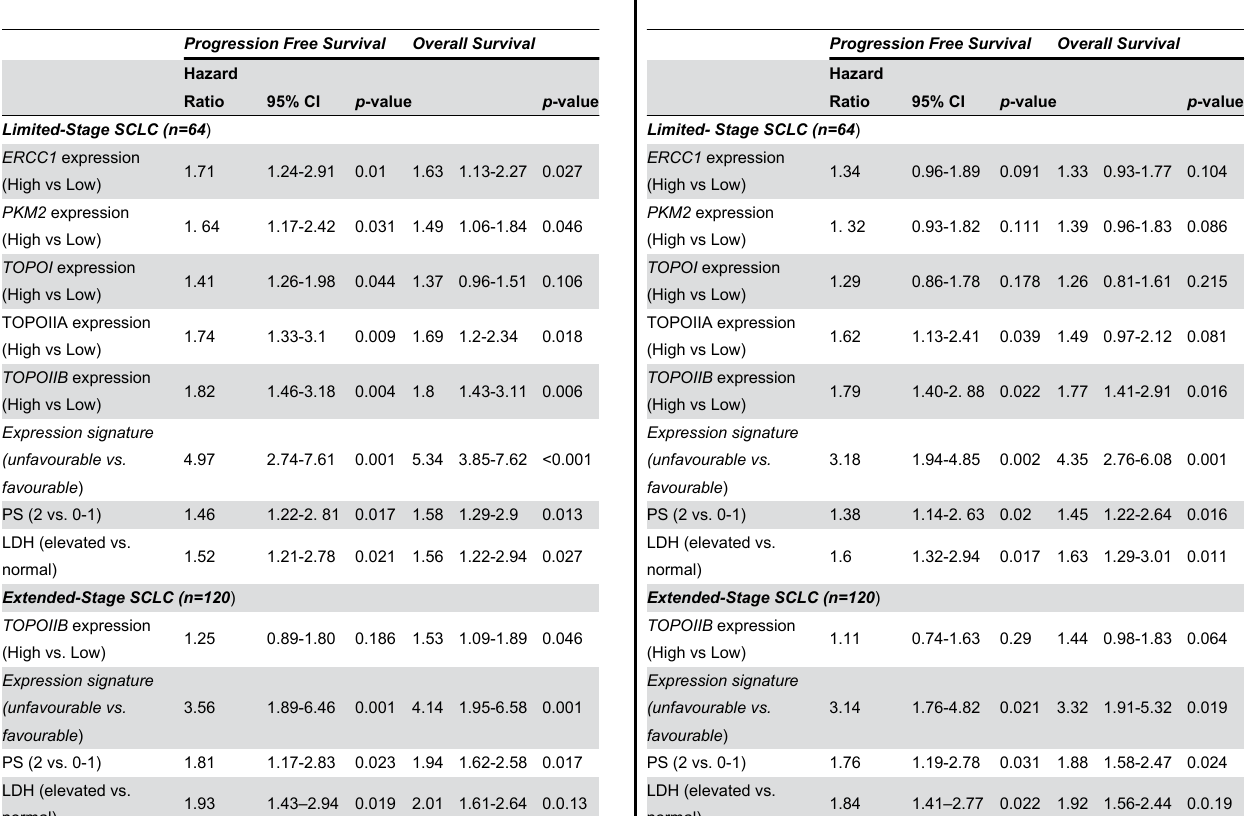
Table 3. Univariate analysis for Progression Free Survival and Overall Survival.